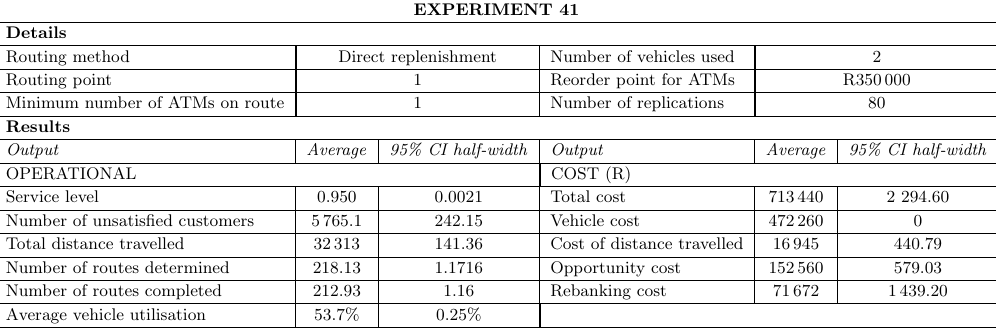
Table 3: Detailed results for Experiment 41. The experiment settings are given under ‘Details.’ It is in contrast to the results of Experiment 11 in Table